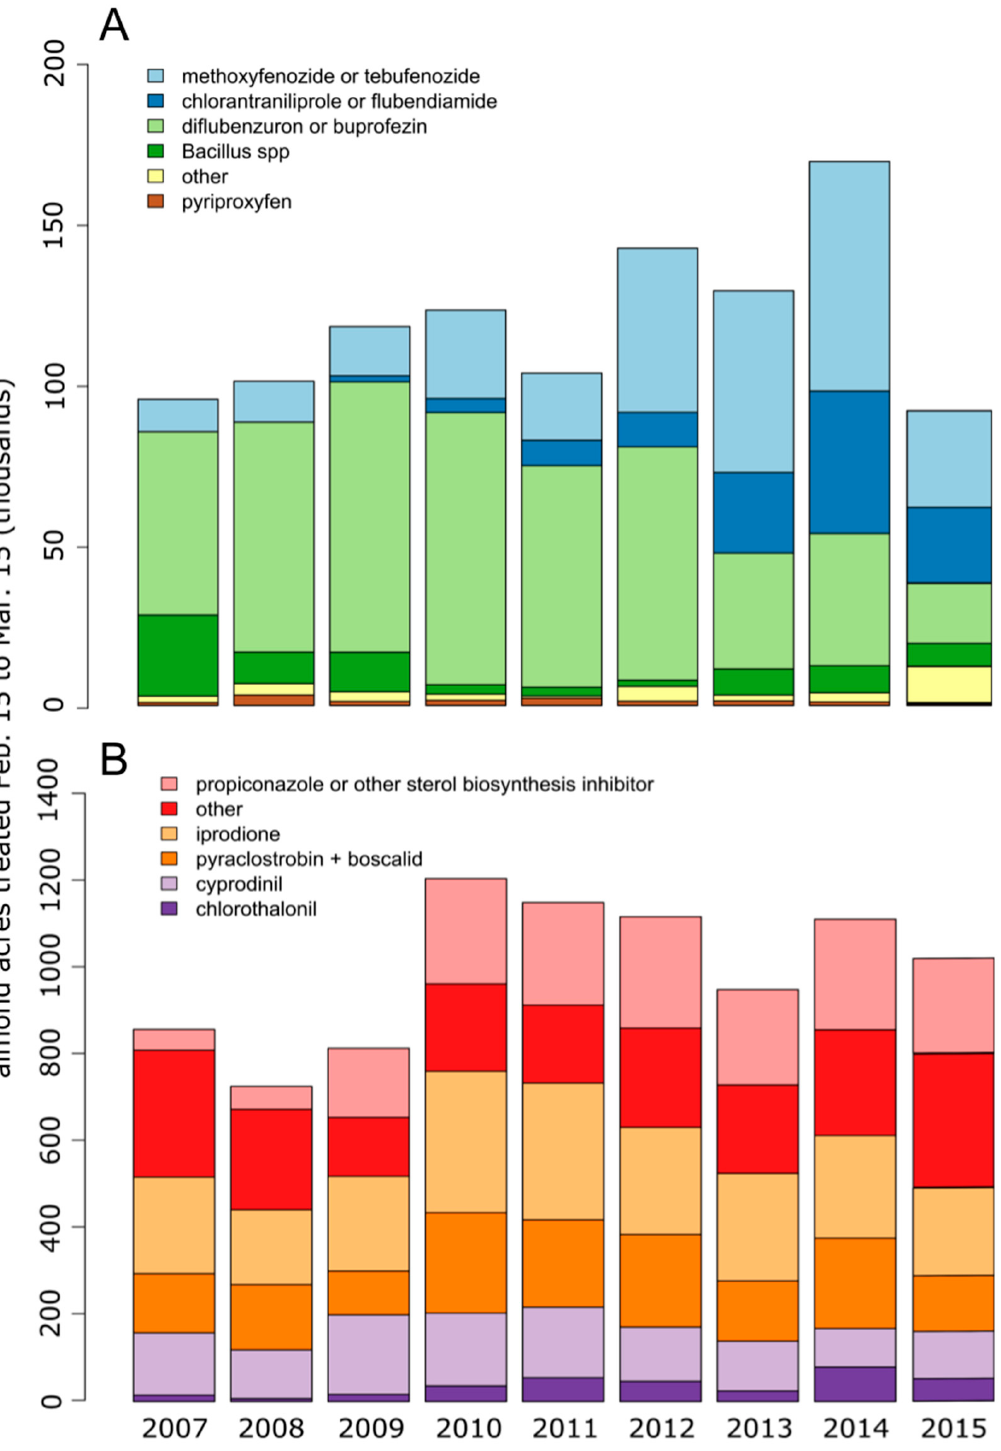
Figure 1. Insecticide ( A ) and fungicide ( B ) use on California almonds for the years 2007–2015 during the blooming period (15 February–15 March). Data downloaded from the California Pesticide Information Portal [4].